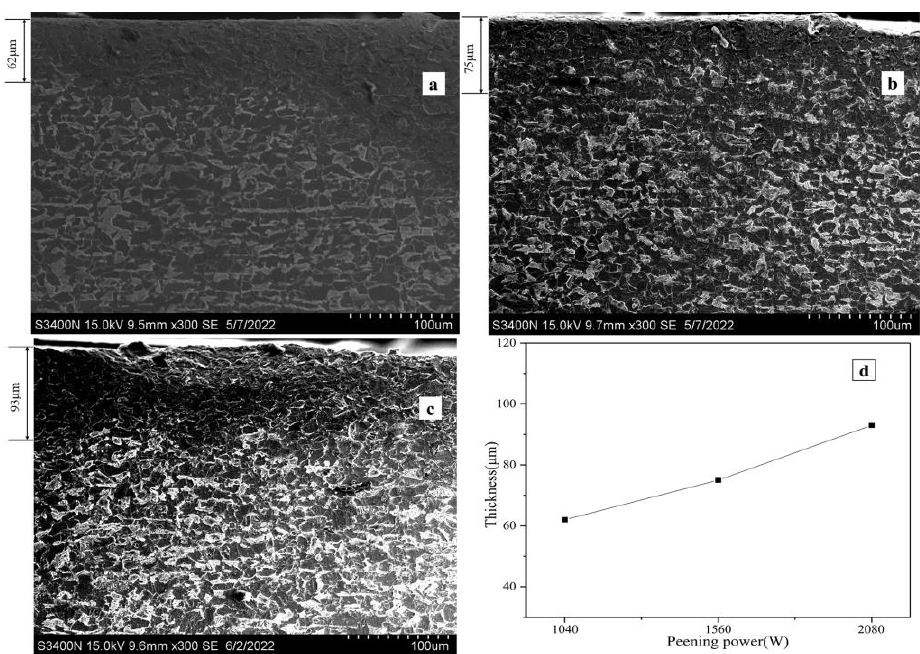
Figure 3. The cross-sectional SEM microstructure images of the 3 mm-200 s-11 mm sample: ( a ) 1040 W; ( b ) 1560 W; ( c ) 2080 W. ( d ) The thickness statistics of the shot peening deformation layer with different levels of power.